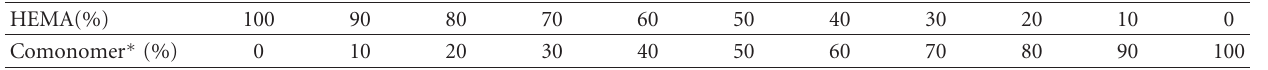
Table 1: Various compositions of HEMA: